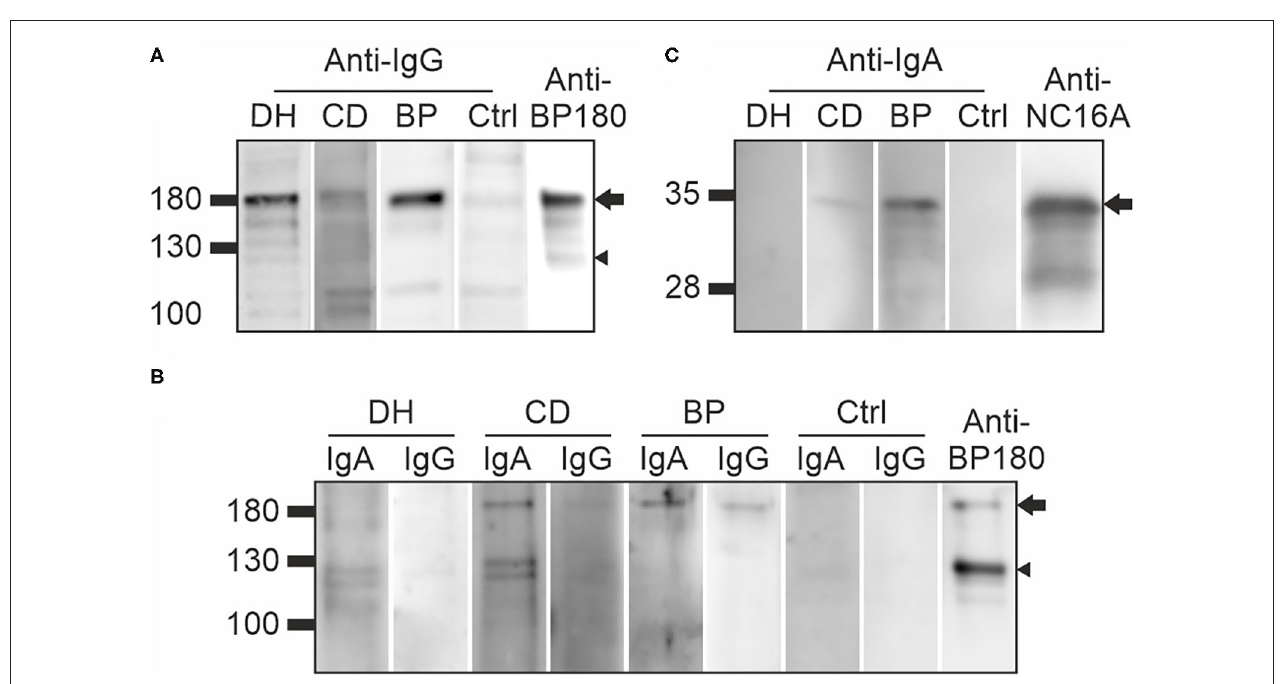
FIGURE 2 | Immunoblotting of DH, CD, and BP sera against full-length and plasmin-digested recombinant BP180, and the recombinant NC16A domain (A) Examples of DH, CD, BP, and control sera IgG autoantibodies that recognized 180 kDa BP180 (arrow) and some also the 120 kDa ectodomain (arrowhead). (B) Examples of DH, CD, BP, and control sera containing IgA and/or IgG autoantibodies that recognize 180 kDa BP180 (arrow) or the 120 kDa ectodomain (arrowhead) after partial plasmin digestion. Specific anti-BP180 antibody was used as a positive control. (C) The recombinant BP180-NC16A domain of 36 kDa was recognized by IgA autoantibodies in the CD and BP samples (arrow), but not the DH and control samples. NC16A-BP180-specific IgG antibody was used as a positive control. BP, bullous pemphigoid; CD, coeliac disease; Ctrl, control; DH, dermatitis herpetiformis.